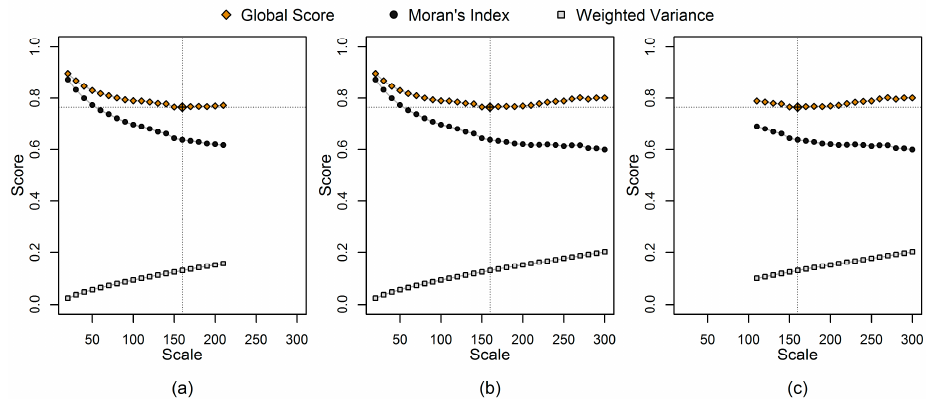
Figure 3. Results for Global Score ( GS ), Moran’s Index ( I ) and Weighted Variance ( v ) calculated for the same set of test segmentations as in Figure 2, using fixed values for normalization this time. ( a ) is restricted to a subset of Scale between 20 and 210, ( b ) is the full set of Scale ranging from 20 to 300 and ( c ) is the subset of Scale ranging from 110 to 300. Regardless of the subset used, segmentation at Scale 160 is reported as optimal.